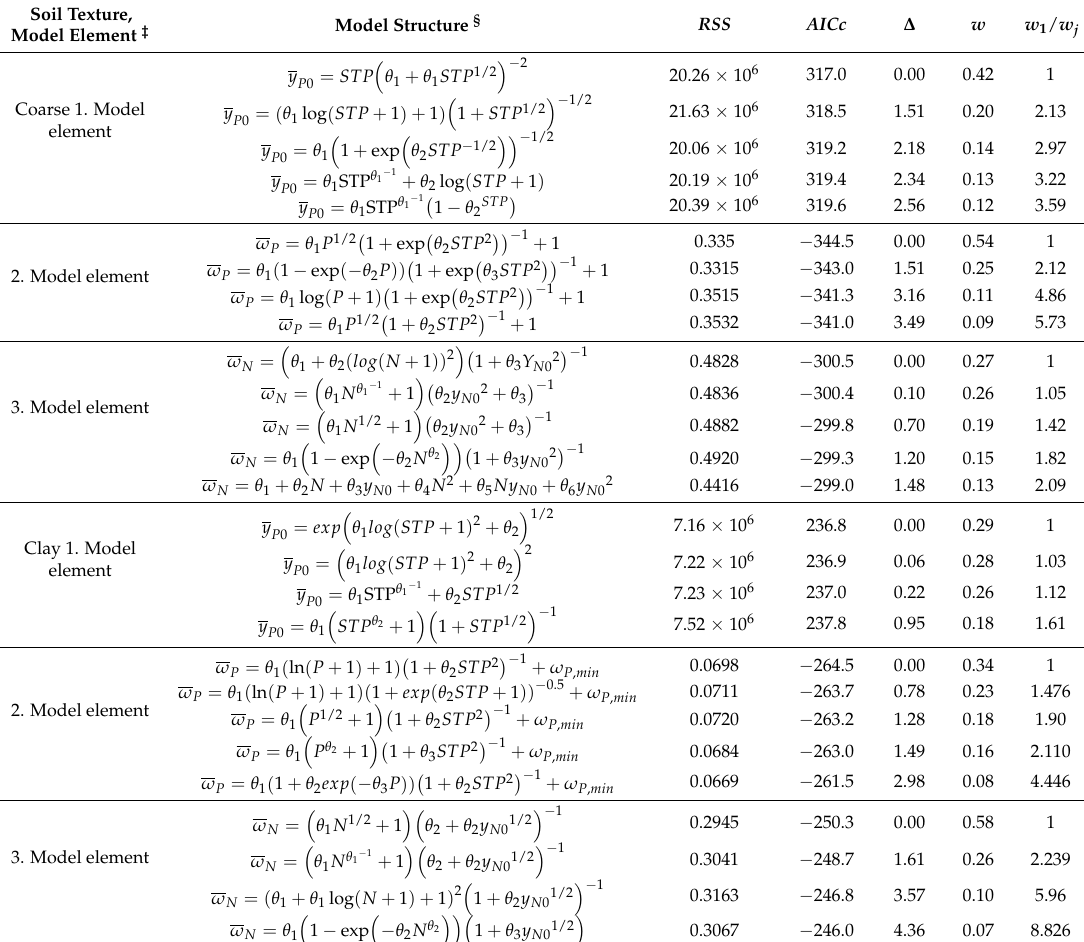
Table A1. The estimated models and the summary of the model ranking results for coarse and clay soils †